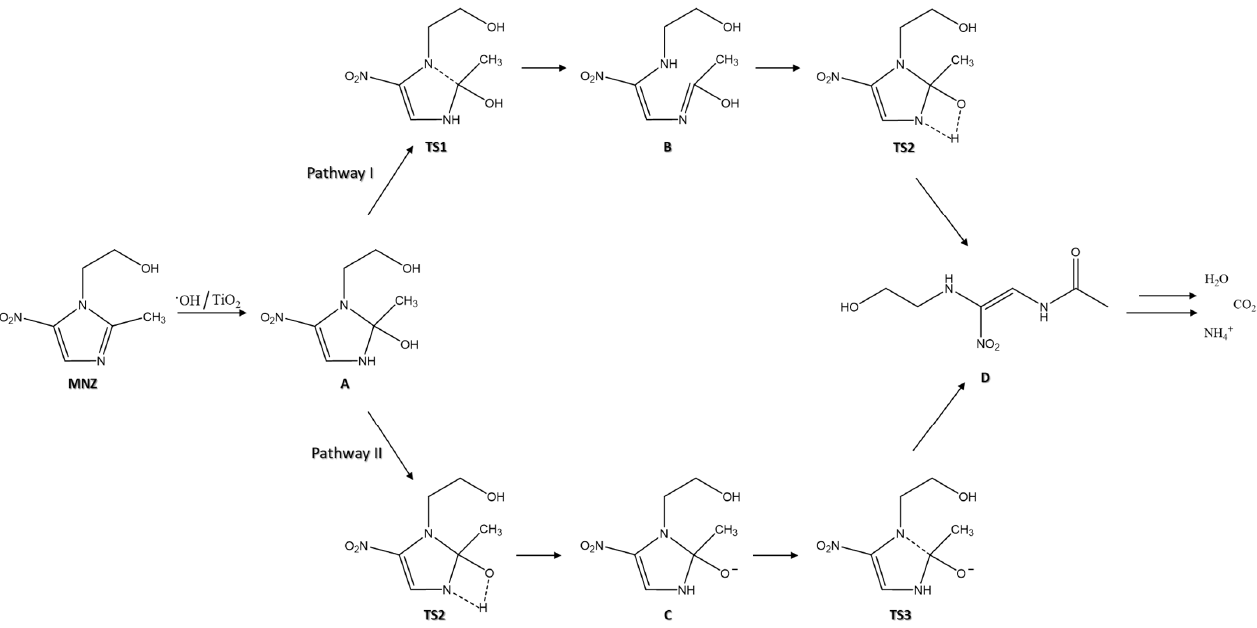
Figure 8. HPLC chromatogram of MNZ (C i =10 mg/L) samples ( a ) before and ( b ) after photocatalytic degradation by 10% Ag@TiO 2 /PVDF-HFP under 5 h of sunlight irradiation.